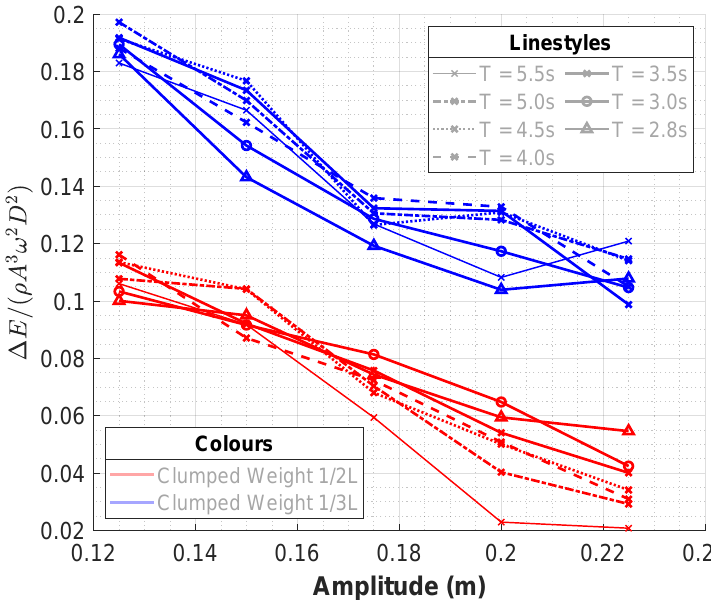
Figure 17. Dimensionless increase of dissipated energy due to the Clumped